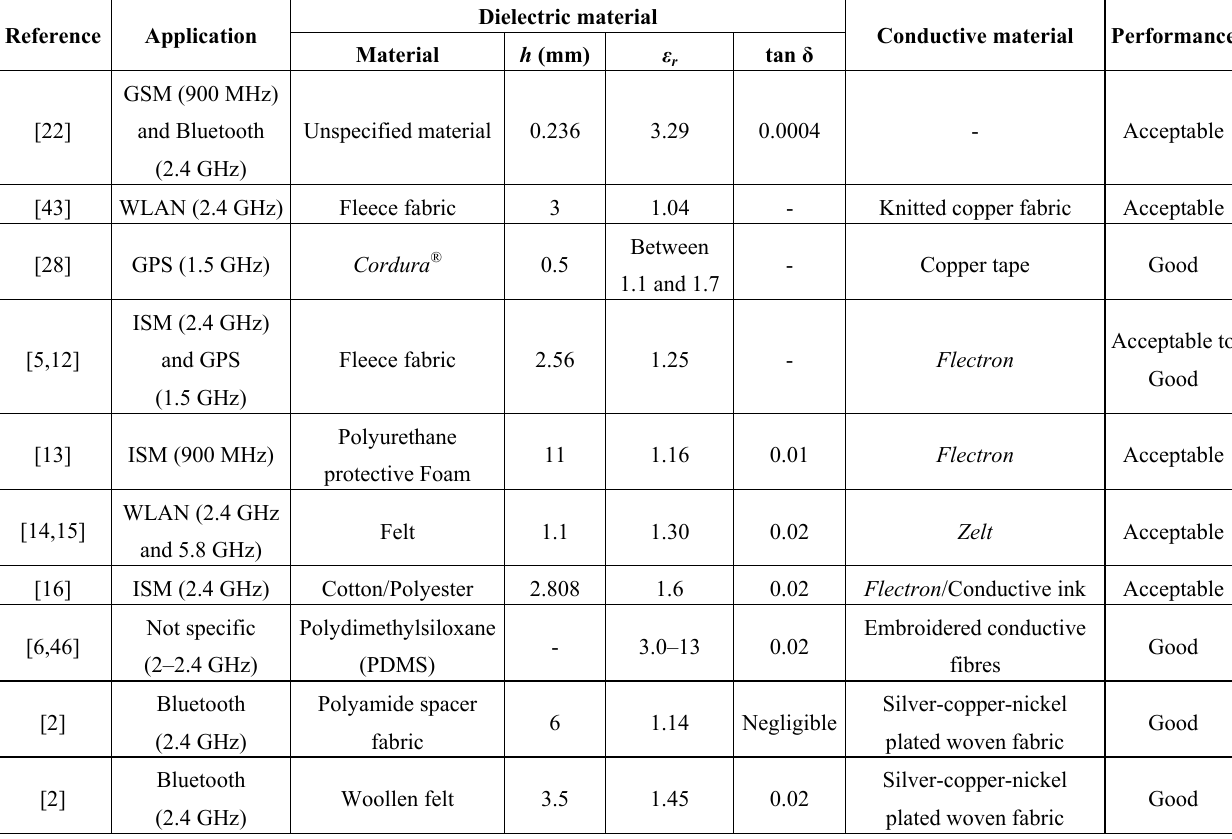
Table 2. Comparison of the textile materials used to design wearable